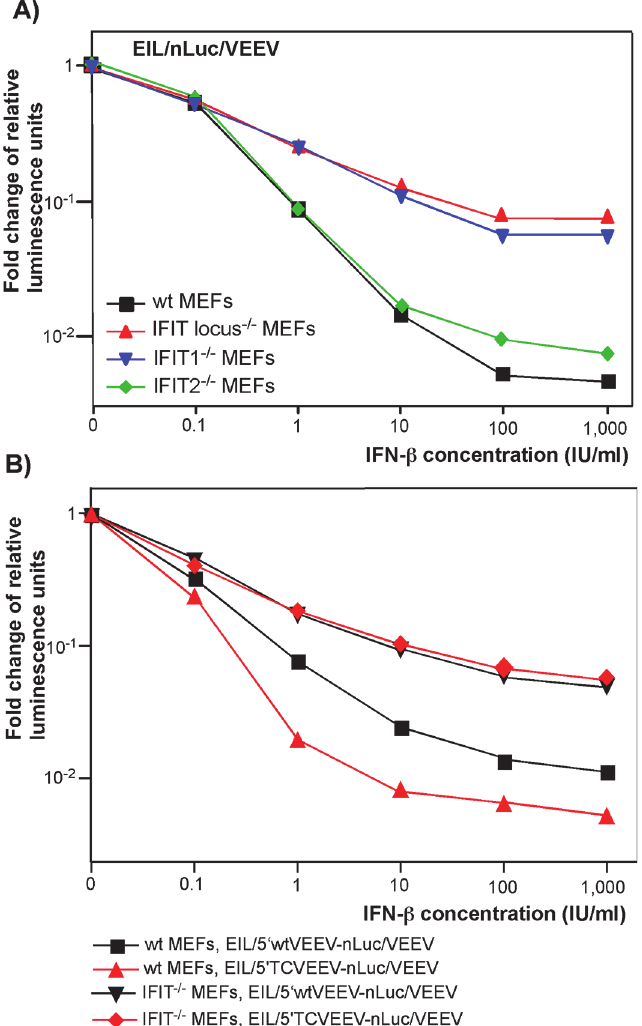
Fig 5. IFIT1 inhibits translation of incoming alphavirus-specific RNAs. (A) Wild type (wt), IFIT1 -/- , IFIT2 -/- or IFIT locus -/- MEF were treated for 20 h with the indicated concentrations of IFN- β or remained mock- treated. Then cells were infected with EIL/nLuc/VEEV at an MOI of 10 PFU/cell for 1 h at 37°C, washed with PBS, and further incubated in complete medium at 37°C. nLuc activity was analyzed at 4 h post infection, and data were normalized to samples from the mock-treated, infected cells. (B) Wt and IFIT1 -/- MEF were treated for 20 h with the indicated concentrations of IFN- β or remained mock-treated. Then cells were infected with EIL/5 ’ wtVEEV-nLuc/VEEV and EIL/5 ’ TCVEEV-nLuc/VEEV viruses. nLuc activity was analyzed at 4 h post infection and normalized to the activity in the samples of the mock-treated, infected cells. One of the reproducible repeated experiments is presented. All of the measurements were performed in triplicates, and standard deviations are too small to be